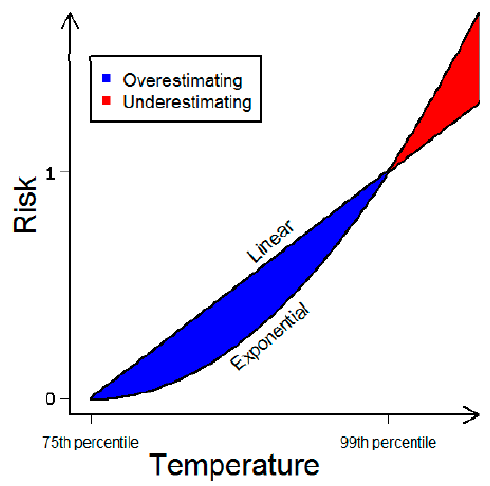
Figure 1. The difference between using a linear and an exponential relationship to describe heat-related mortality, assuming that the exponential relationship is the correct one.